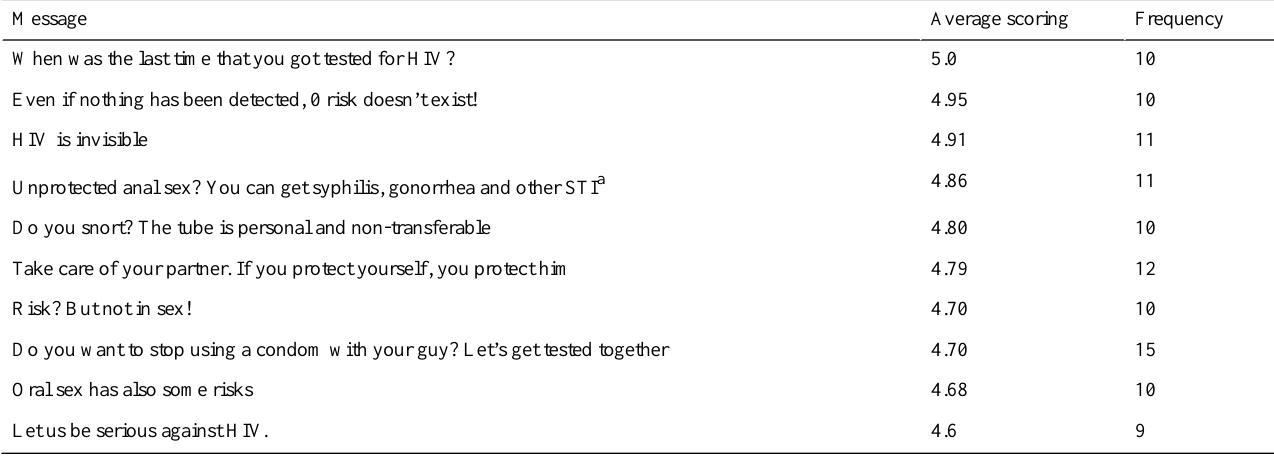
Table 3. Messages sent by the system scored with the highest rating by the participants.